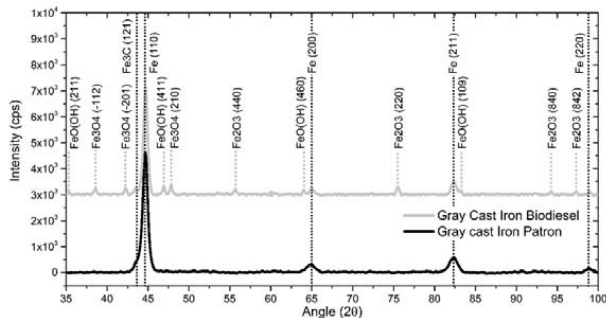
Figure 8. XRD spectrum of the gray cast iron before and after exposure to palm biodiesel at 1320 h in OC.